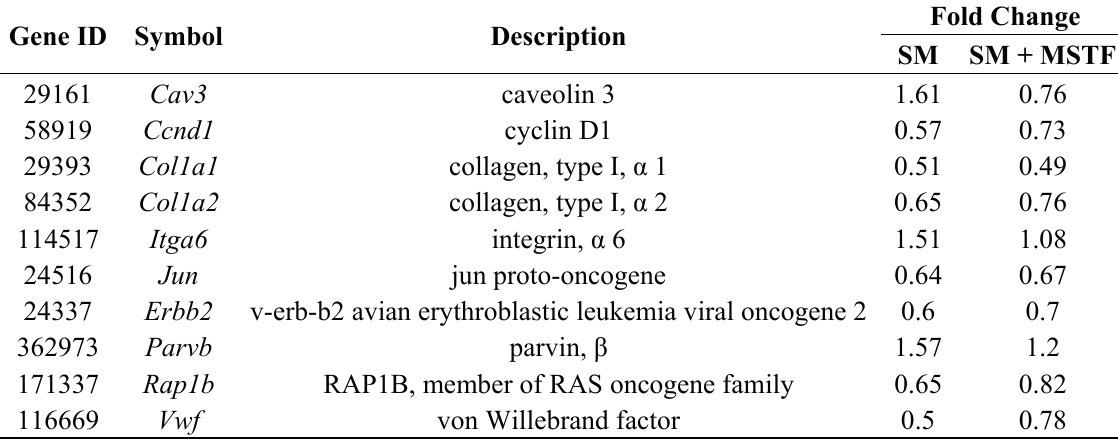
Table 4. List of 10 genes involved in focal adhesion. These SM-induced alterations of expression were abolished or attenuated by MSTF